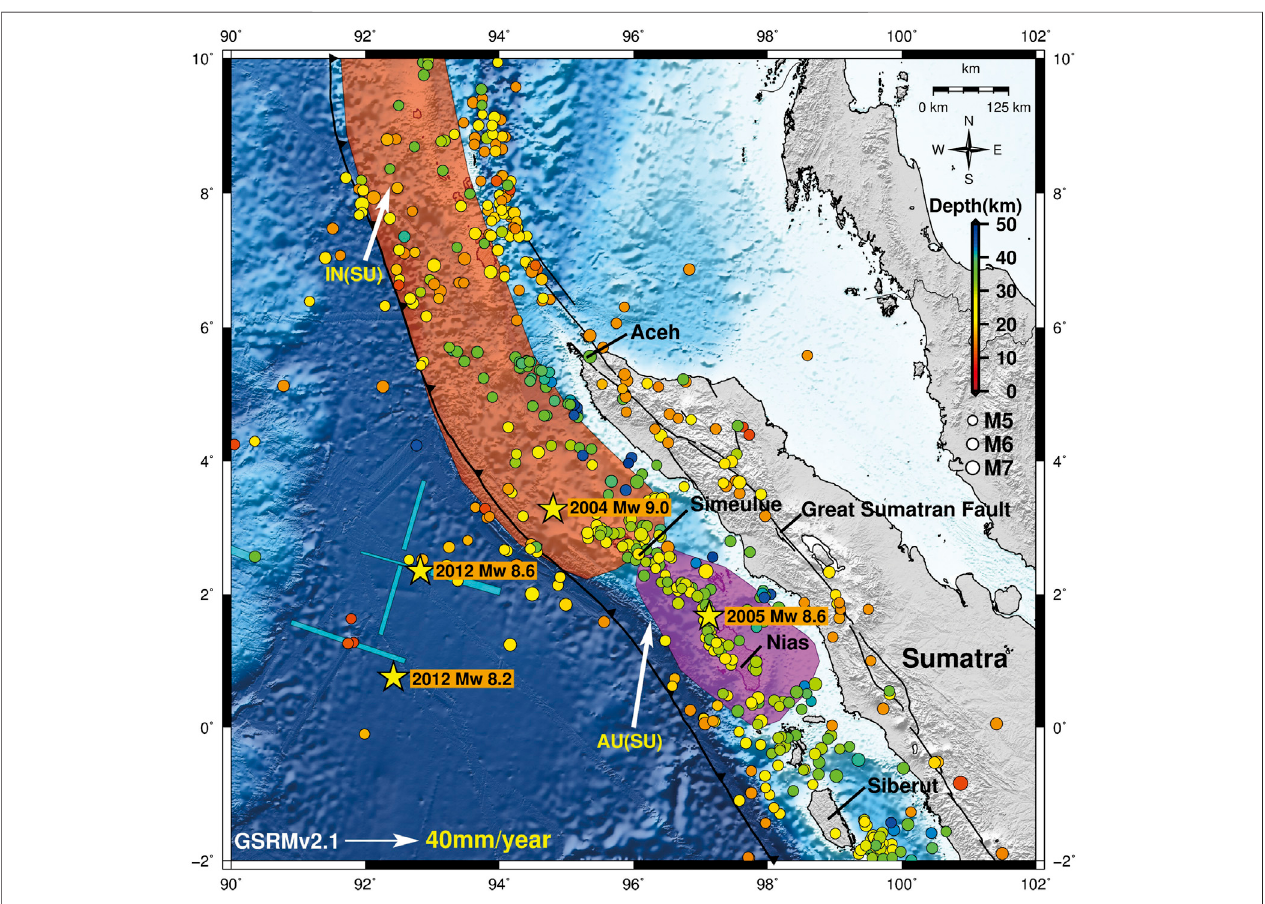
FIGURE1 | Map illustrating the distribution ofseismic activity with Mw ≥ 5.0 and depth ≤ 50 kmfrom theISC-GEM earthquake catalog (Storchaket al., 2015) from 1907to2015.Theepicentersofthelarge mainshocks areindicated byyellow starsand coloredareas indicatetherupture areas ofthe2004Sumatra-Andaman(brown) and 2005 Nias-Simeulue (magenta) earthquakes. The white arrows indicate the movement of the Indian and Australian (upper left and lower right, respectively) Plates withrespect tothe Sunda plate, asestimated by theGSRMv2.1 platemotion model of Kreemer et al. (2014). Background bathymetry/topography is from GEBCO (Kapoor, 1981). IN: Indian Plate, AU: Australian Plate, SU: Sunda Plate.